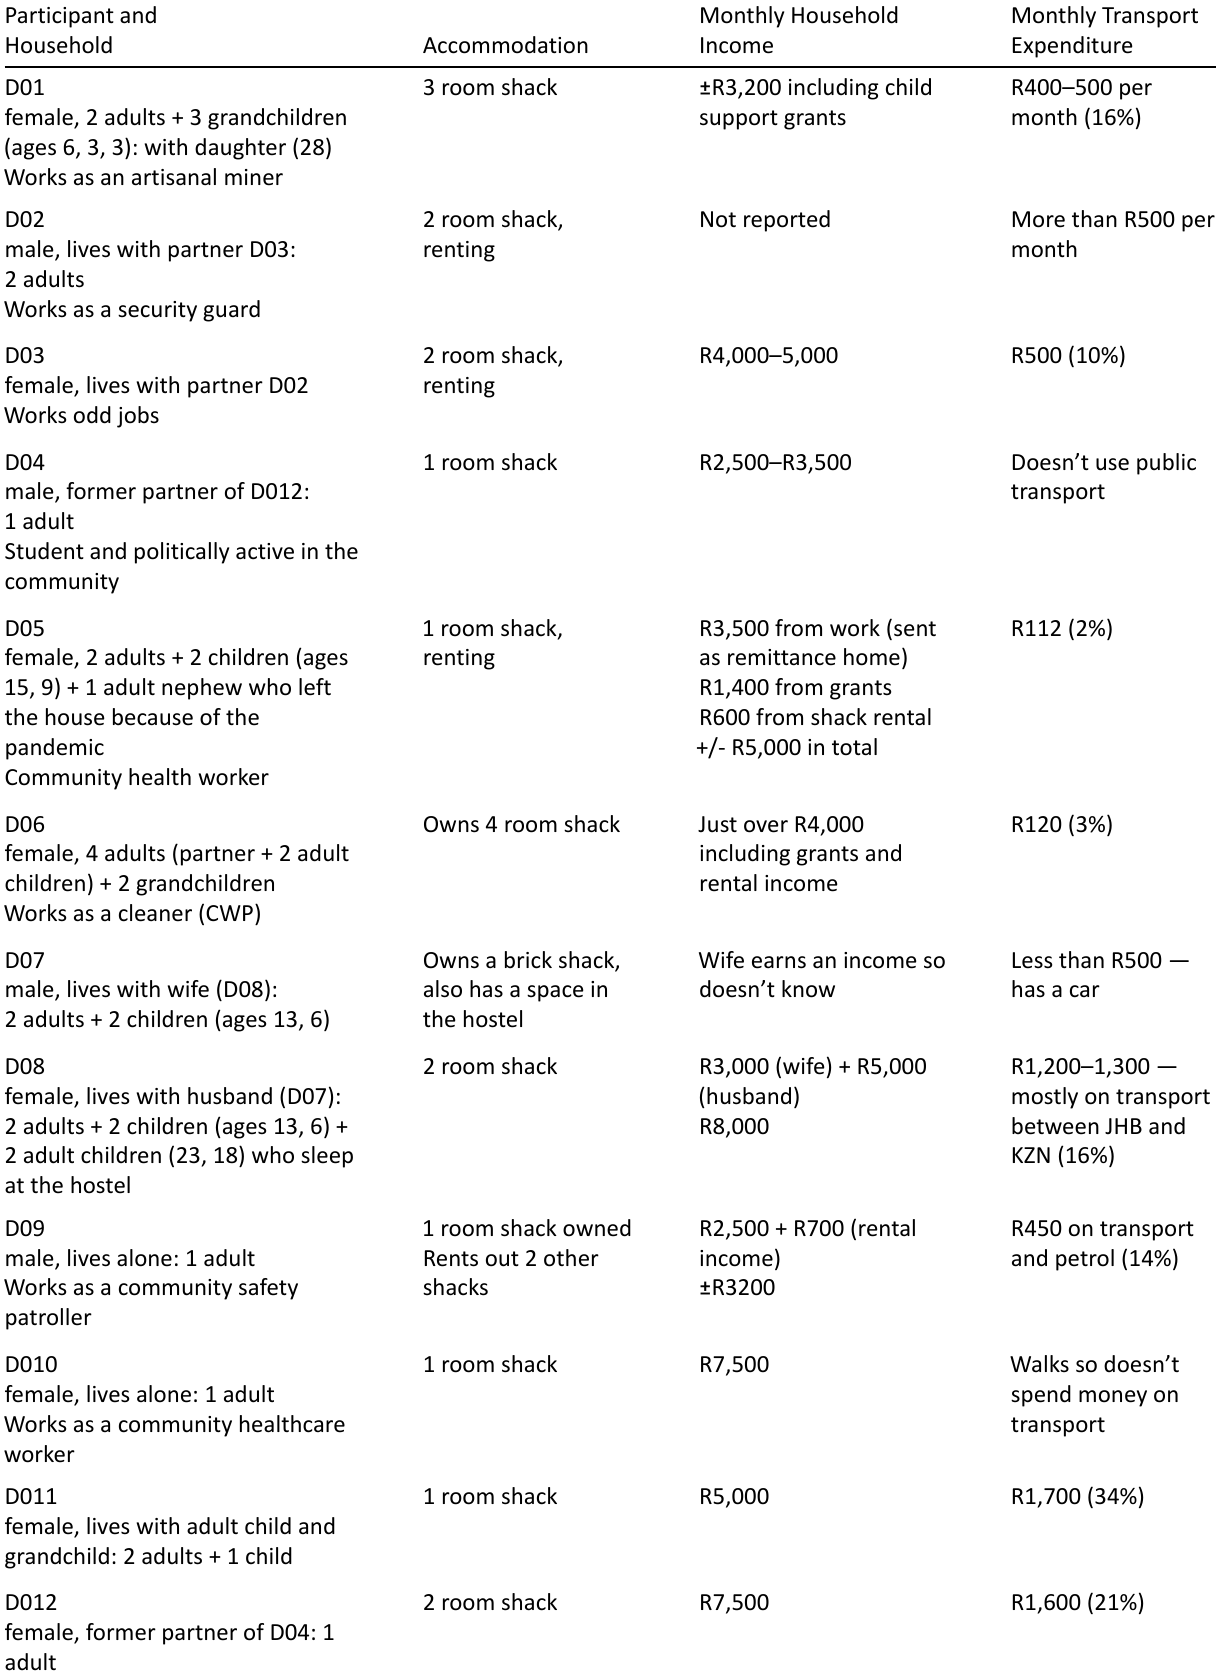
Table 1. The 2020 Denver study consisted of 12 participants, including eight women and four men from nine